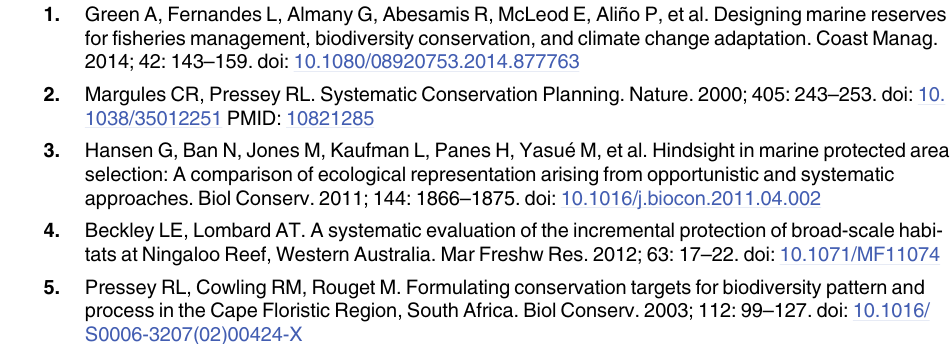
S3 Table. Rationale for developing resilience conservation objectives. S4 Table. Opportunity cost values for different human activities within Ningaloo Marine